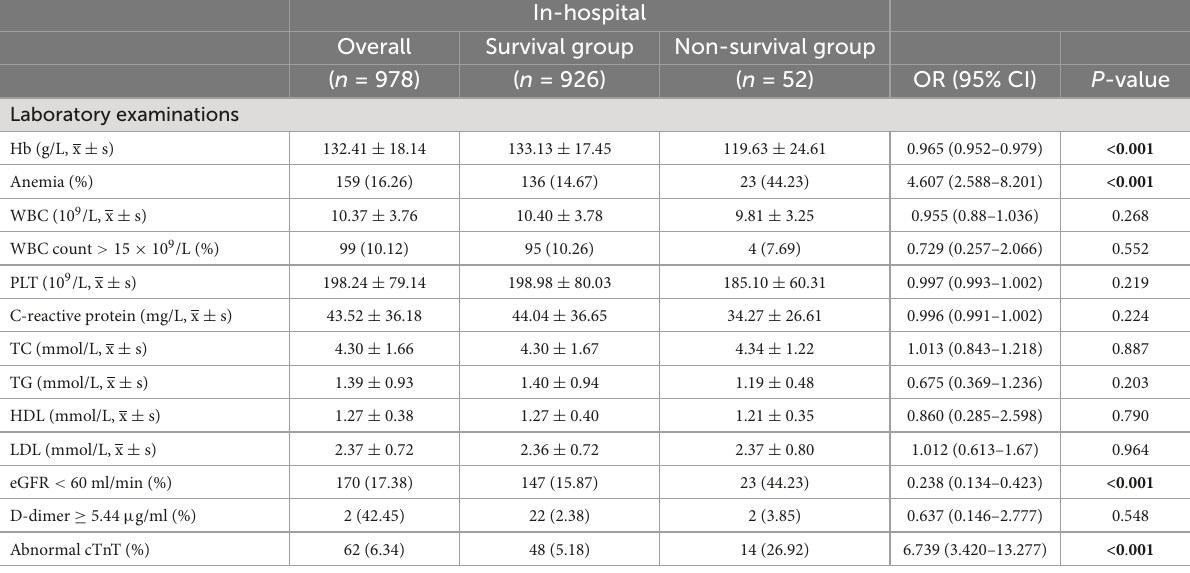
TABLE 4 Laboratory examinations of all patients with Stanford type B aortic dissection.